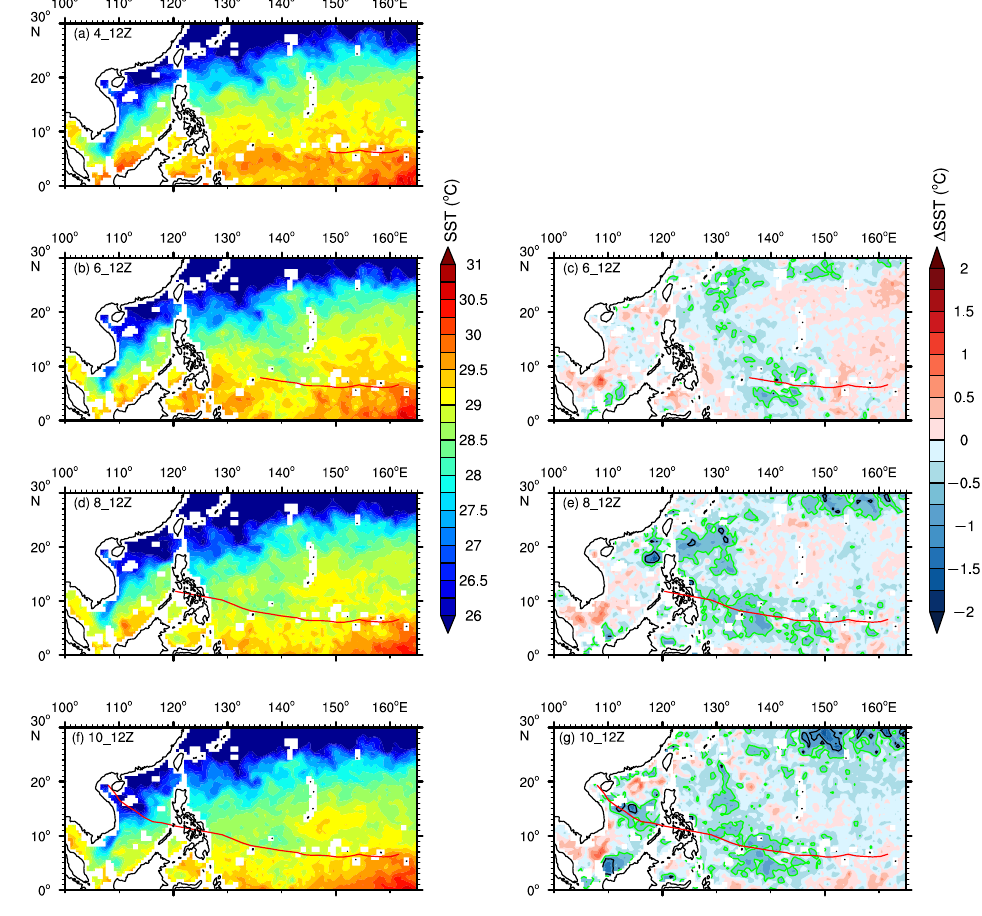
Figure 7. Satellite-based sea surface temperature during super-typhoon Haiyan. Left panels ( a , b , d , f ) show the sea surface temperature at 4_12Z, 6_12Z, 8_12Z and 10_12Z respectively. Right panels ( c , e , g ) are the sea surface temperature change for 6_12Z, 8_12Z and 10_12Z respectively, where the initial time is set as 4_12Z. The contours represent 0.5 ◦ C (green) and 1.0 ◦ C (black)